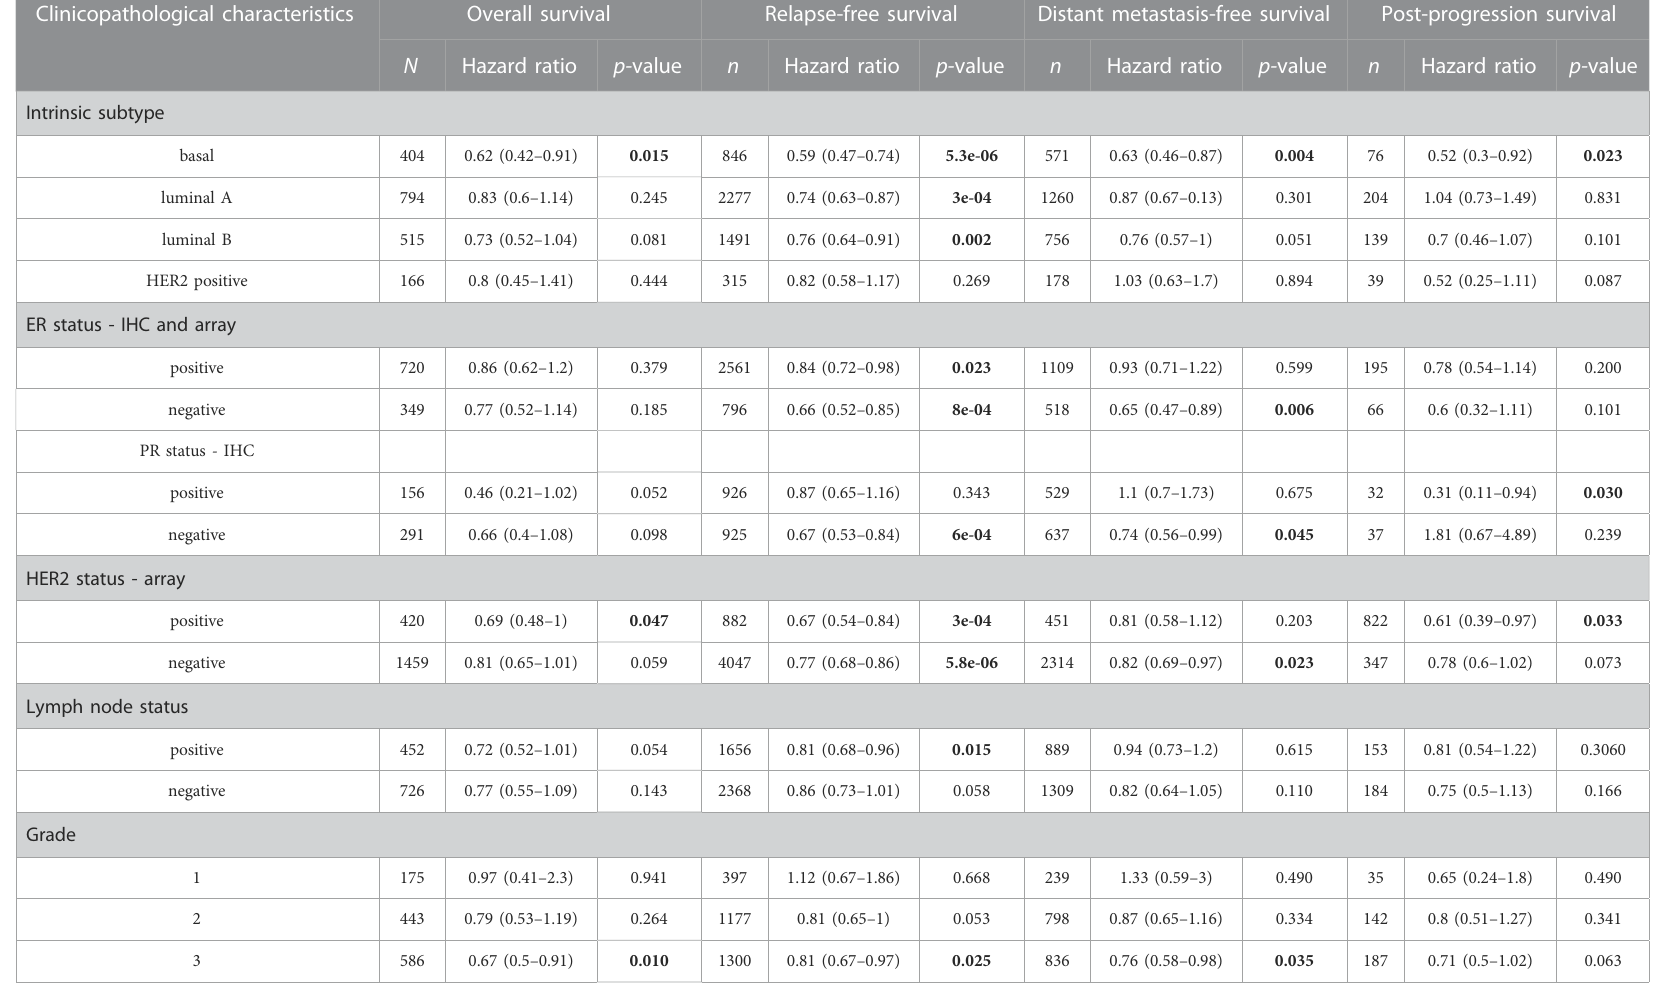
TABLE 1 Correlation of NR1H3 gene expression with OS, RFS, DMFS and PPS in breast cancer with different clinicopathological